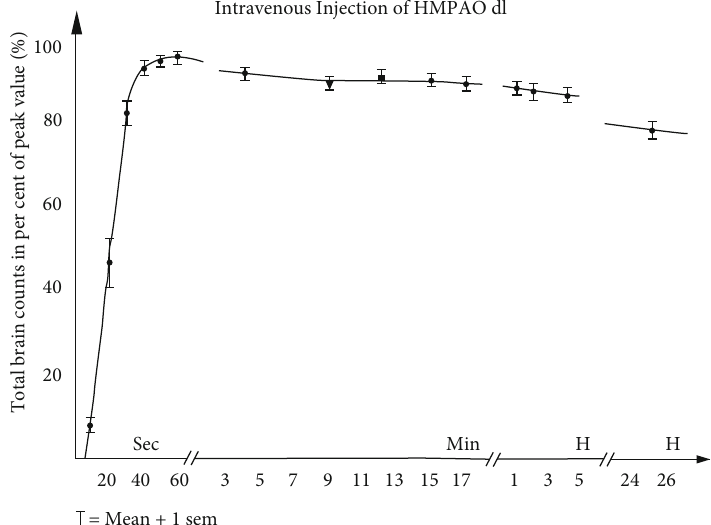
Figure 1: Time activity curve for Tc-99m HMPAO (corrected for radioactive decay). Note that all brain uptake has occurred by the fi rst 60 seconds after IV injection and then very little loss of tracer molecules occurred over hours (counts decreasing mainly by radioactive 6-hour half-life decay of